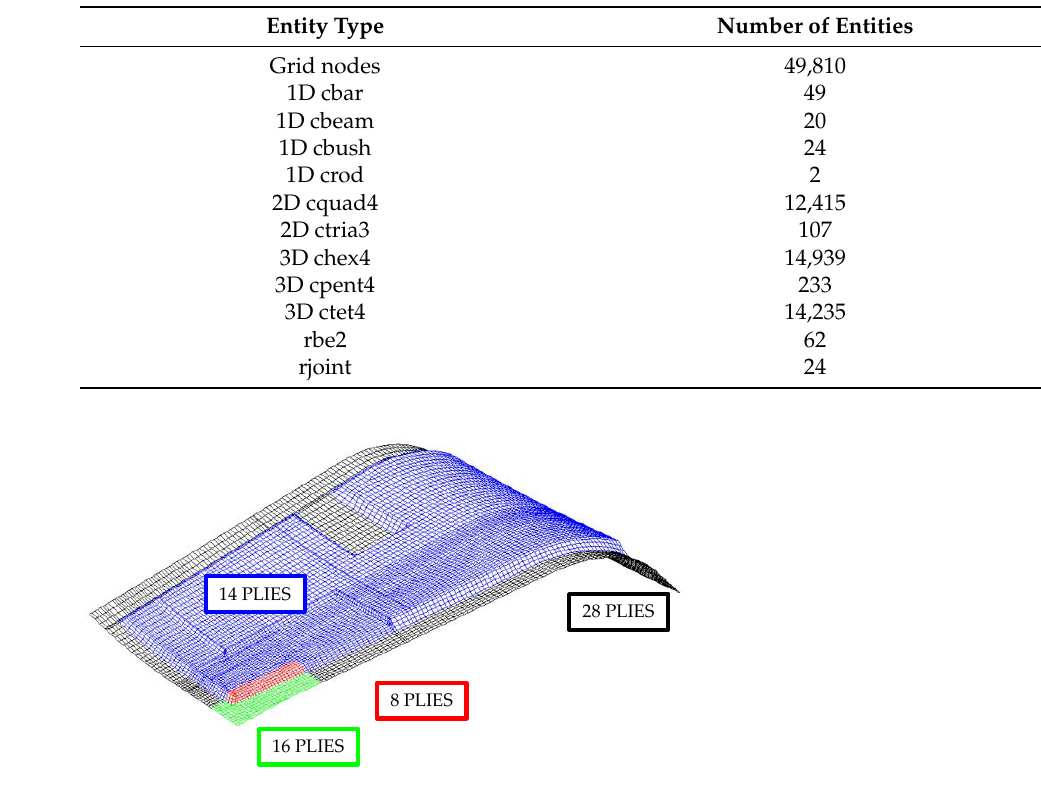
Figure 6. Laminate FE model: mapping of plies distribution. Table 2. Stacking sequences.